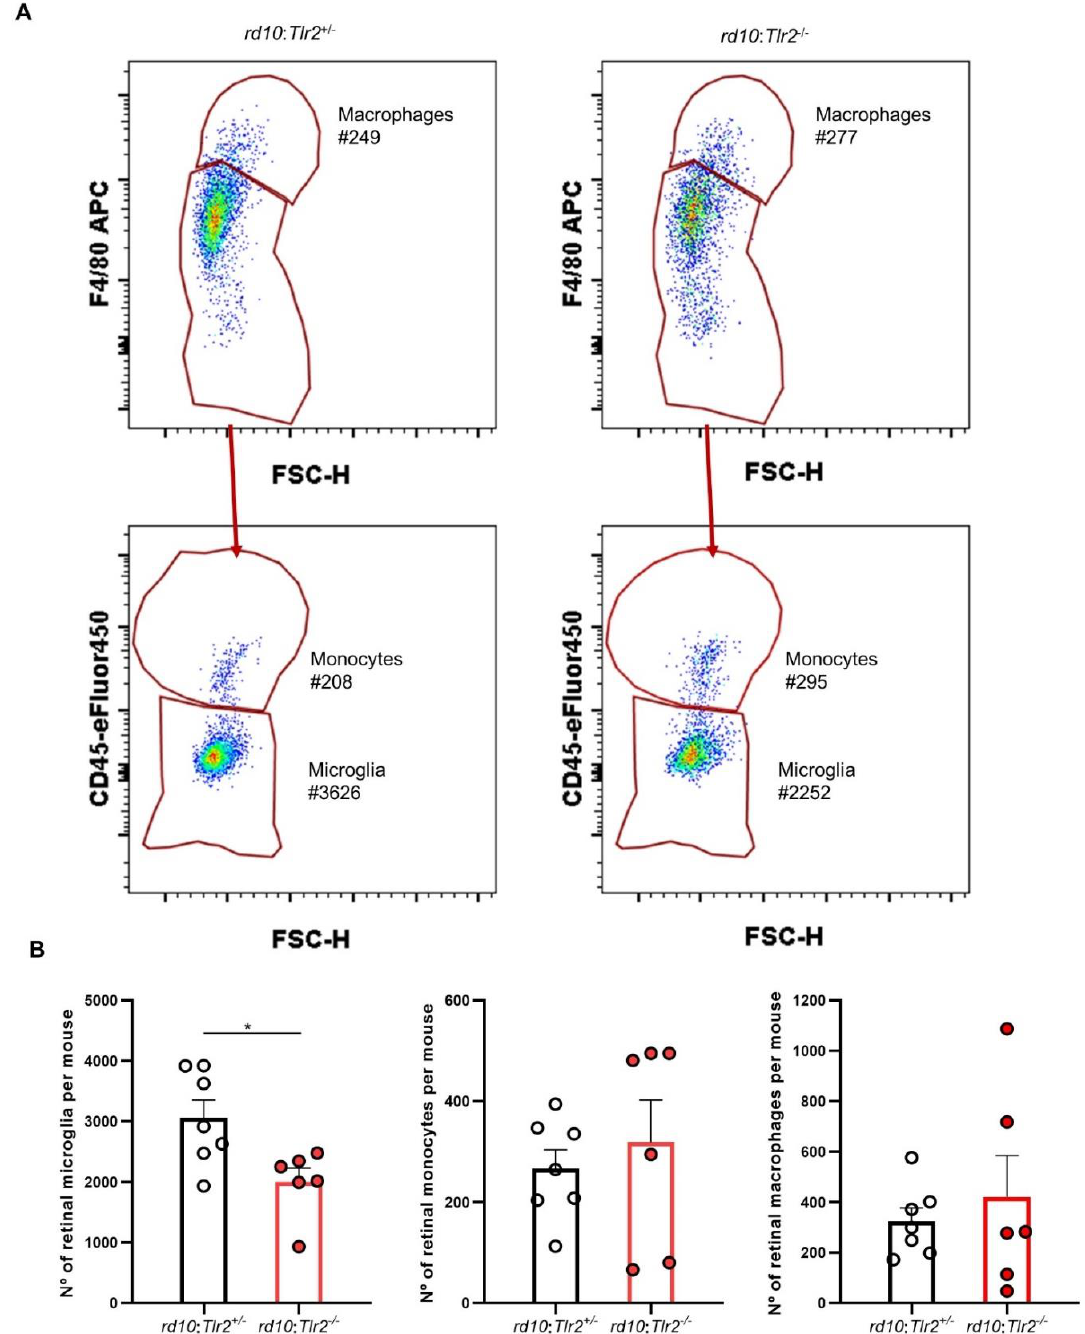
Figure 6. Flow cytometry analysis of myeloid cell population in rd10:Tlr2 +/ − and rd10:Tlr2 − / − retinas. P25 retinas were subjected to flow cytometry analysis by surface staining with antibodies against CD11b, F4/80, and CD45, and subpopulations were defined as described in Figure S2. ( A ) Representative plots. Each gate shows the total cell count for each subpopulation. ( B ) Graphs show the number of cells in each myeloid cell subpopulation. Dots represent individual animals, while bars represent the mean (+SEM) of each group. n = 6–7 mice. * p < 0.05 (Mann-Whitney U